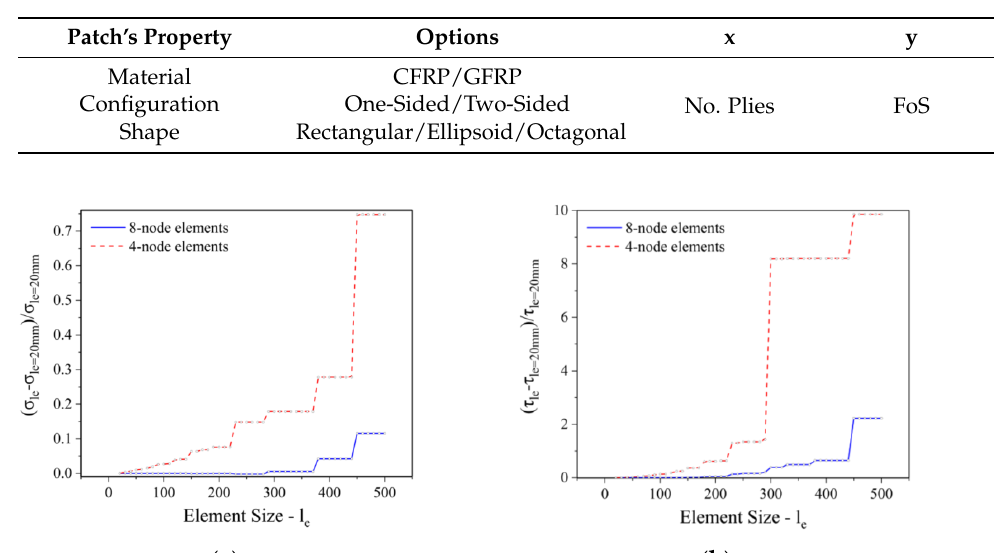
Table 3. Patch’s properties evaluated through OFAT analyses.